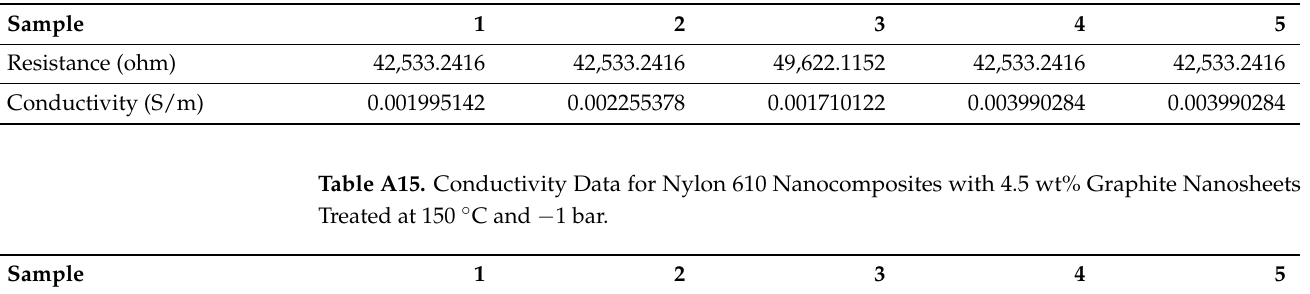
Table A14. Conductivity Data for Nylon 610 Nanocomposites with 3.5 wt% Graphite Nanosheets Treated at 150 ◦ C and − 1 bar.